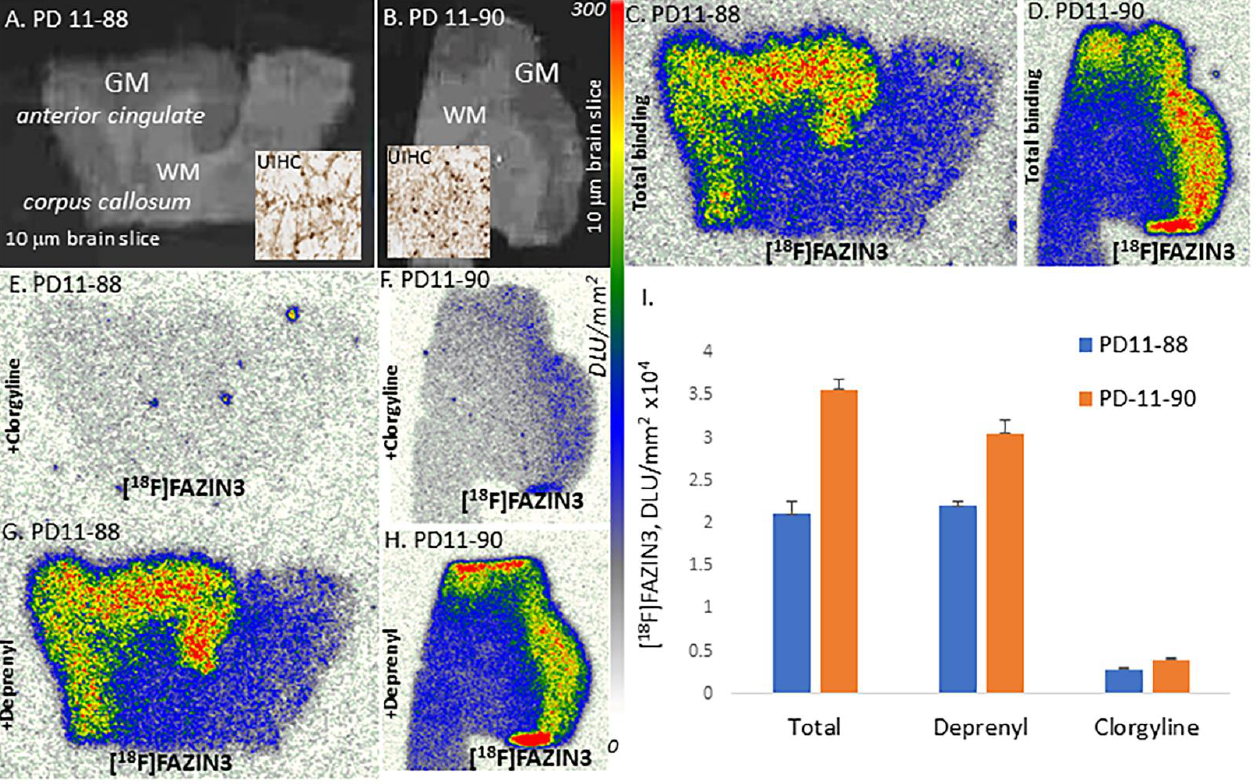
concentration in PD (compared to CN subjects), higher MAO-A binding by [ 18 F]FAZIN3 is